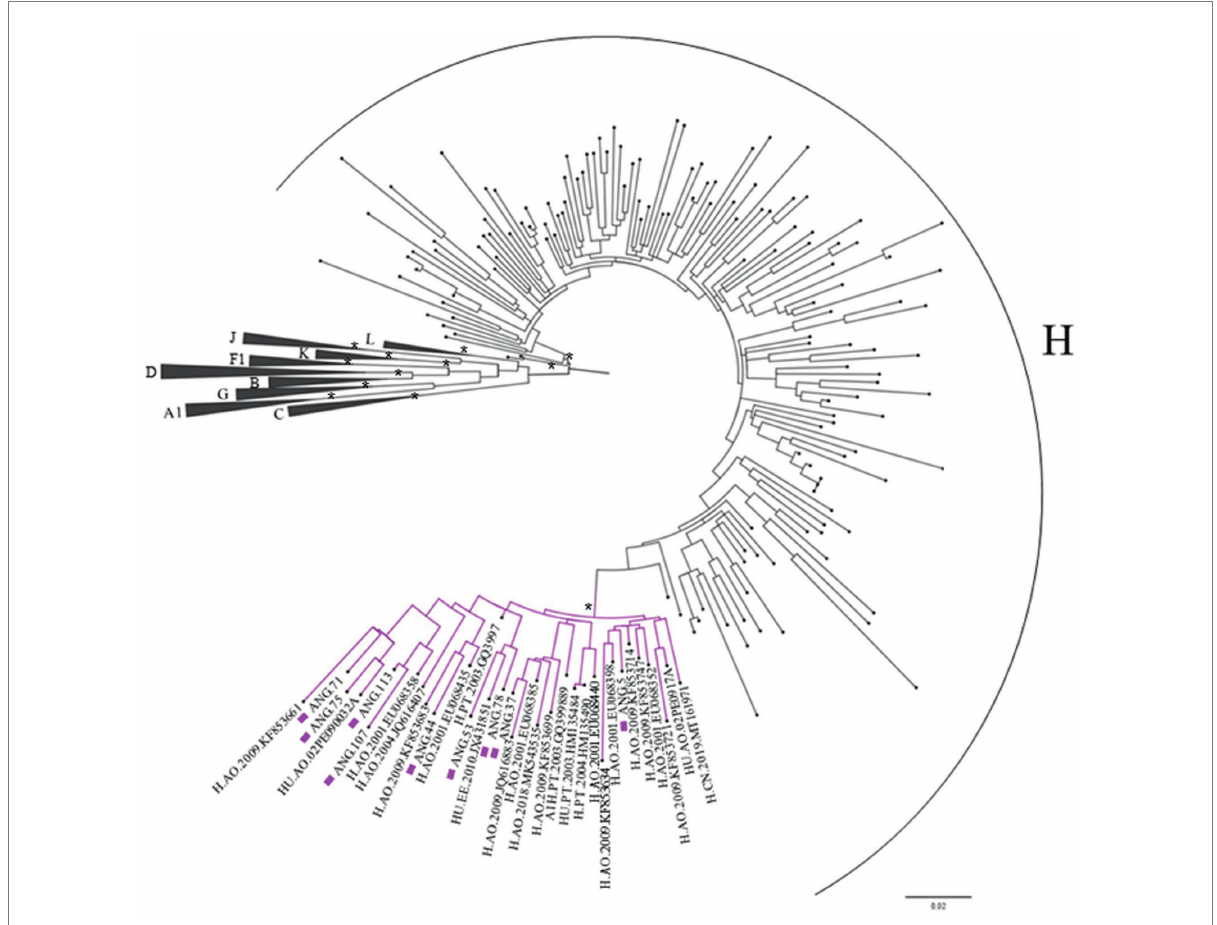
FIGURE 3 Maximum likelihood (ML) tree of Pol fragment (2,261–3,274 relative to the HXB2 reference) implementing nucleotide substitution model General Time Reversible (GTR), indicating the phylogenetic relationships between the studied sequences and those retrieved from BLAST. Approximate likelihood ratio test (ALRT) values are represented only if >0.90 with asterisk. The sequences belonging to the CRF124_cpx are depicted with purple squares and their cluster are highlighted in